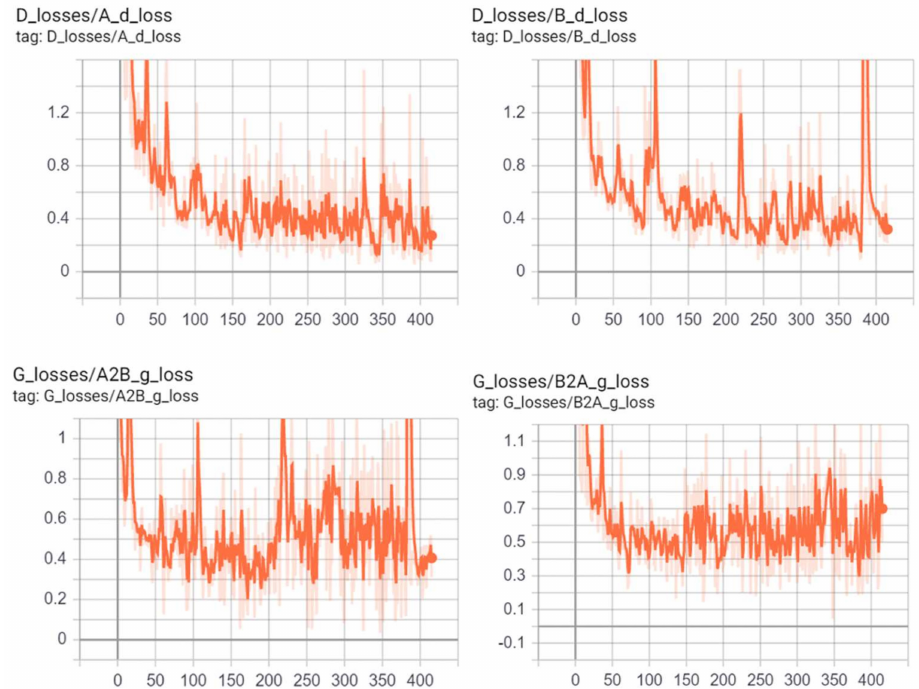
Figure 11. Example of discriminators and generators losses of CycleGAN during